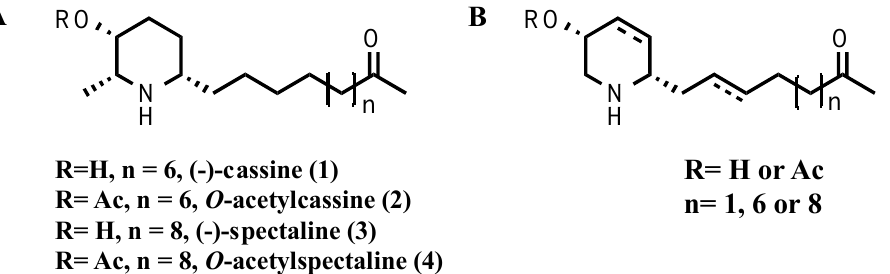
Figure 1. ( A ): Chemical structures of natural products (-)-cassine ( 1 ), (-)-spectaline ( 3 ), O-acetylspectaline ( 4 ) and semi-synthetic derivative O-acetylcassine ( 2 ). ( B ): General structures of 3-hydroxypiperidines investigated in this work.